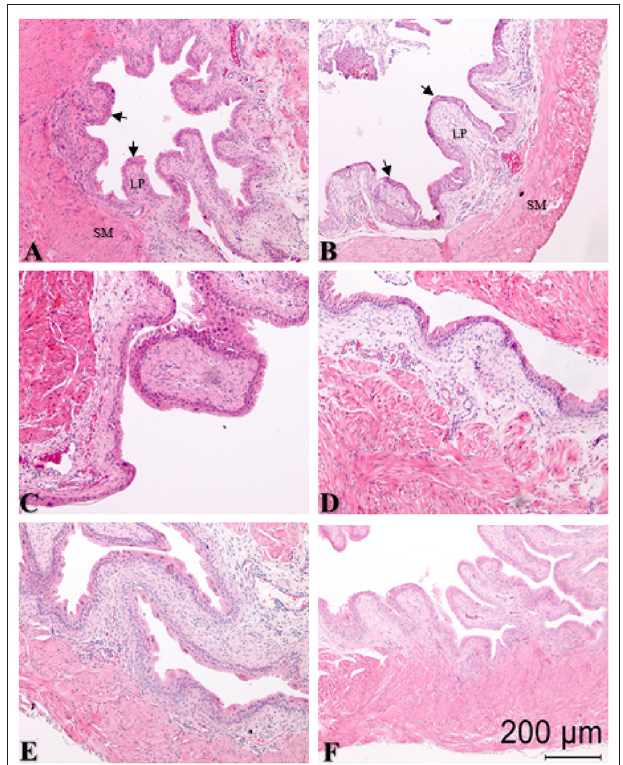
FIGURE 4 | Representative sections of hematoxylin and eosin (H&E) stained bladder cross-sections from all groups ( N = 6/group) with pre-treatment for 10 min followed by bladder protease activated receptor-4 (PAR4) or scrambled peptide infusion for 1 h. Arrows in panels (A,B) show edge of urothelium; lamina propria (LP) and smooth muscle (SM) are also indicated. (A) PBS pre-treatment-scrambled treatment; (B) PBS pre-treatment-PAR4 treatment; (C) N-acetylcysteine amide (NACA) pre-treatment-PAR4 treatment; (D) Methylcellulose (Methcell; solvent) pre-treatment-PAR4 treatment; (E) FR 180204 (FR) pre-treatment-PAR4 treatment; (F) Ethyl pyruvate (EP) pre-treatment-PAR4 treatment. No significant changes in edema ( F = 1.151, ns) or inflammation ( F = 0.994; ns) scores were noted in all groups when compared to control ( A , Table 3 ; ns, not significant at p <